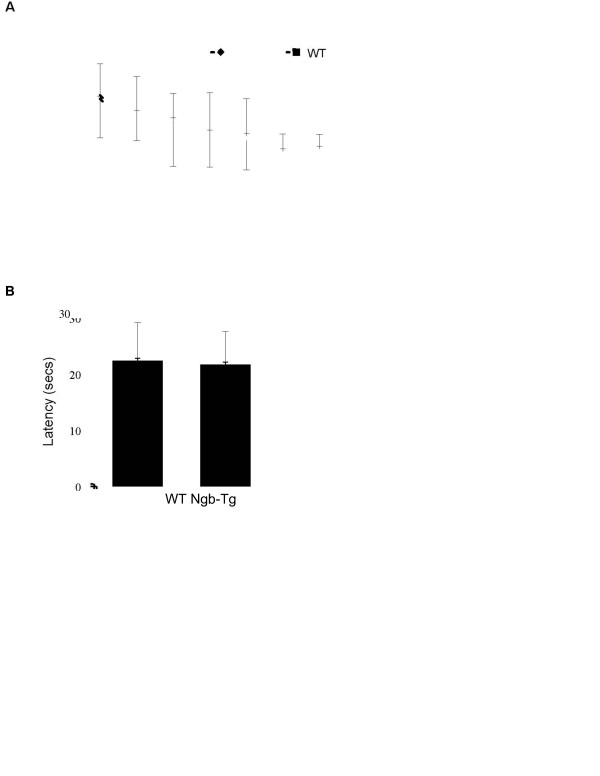
Spatial memory acquisitions in WT and Ngb-Tg mice after TBI.A. Morris water maze latencies were measured on days 15-21 for hidden and visible platform trials after TBI. B. Morris water maze latencies were measured on days 15-21 for probe trials after TBI. Data were expressed as mean ± SD. n = 15 for WT and 11 for Ngb-Tg per group, respectively.